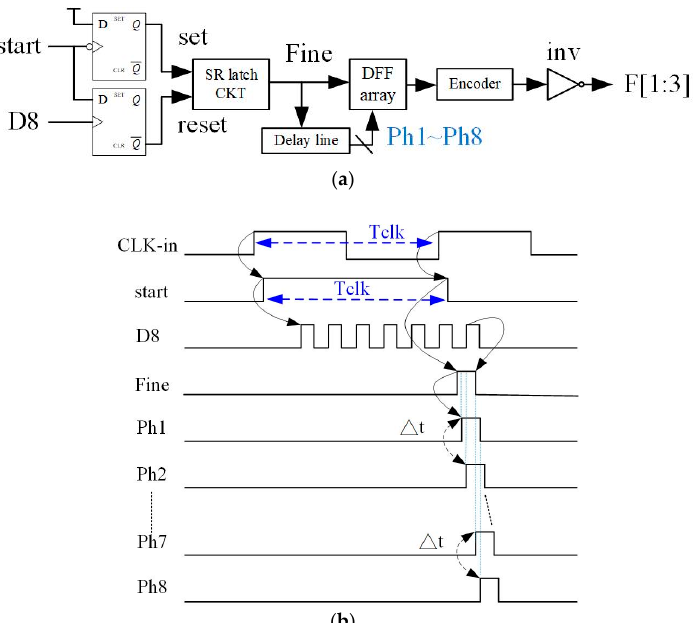
Figure 4. ( a ) The block diagram and ( b ) the timing diagram of the Fine TDC.